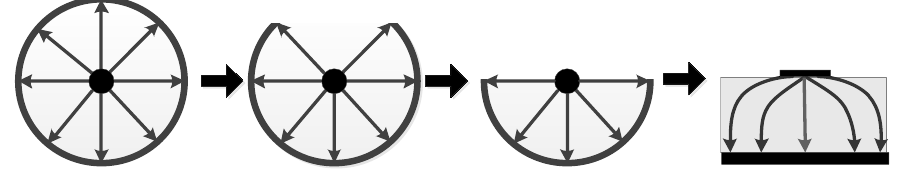
Figure 11. Transition from coaxial TEM mode to microstrip quasi TEM mode.